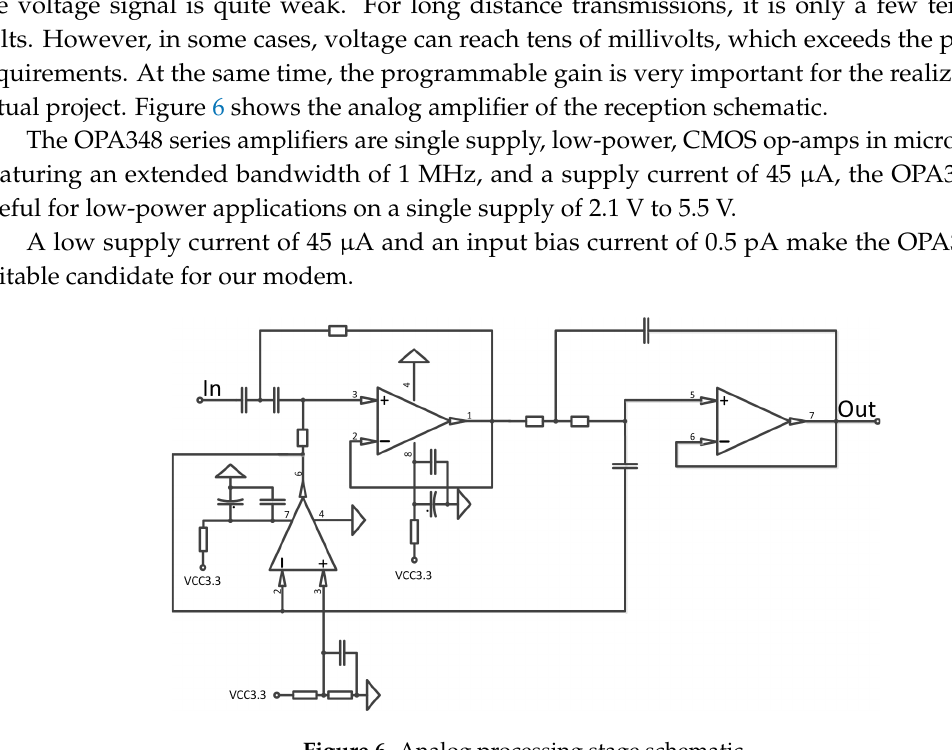
Figure 6. Analog processing stage